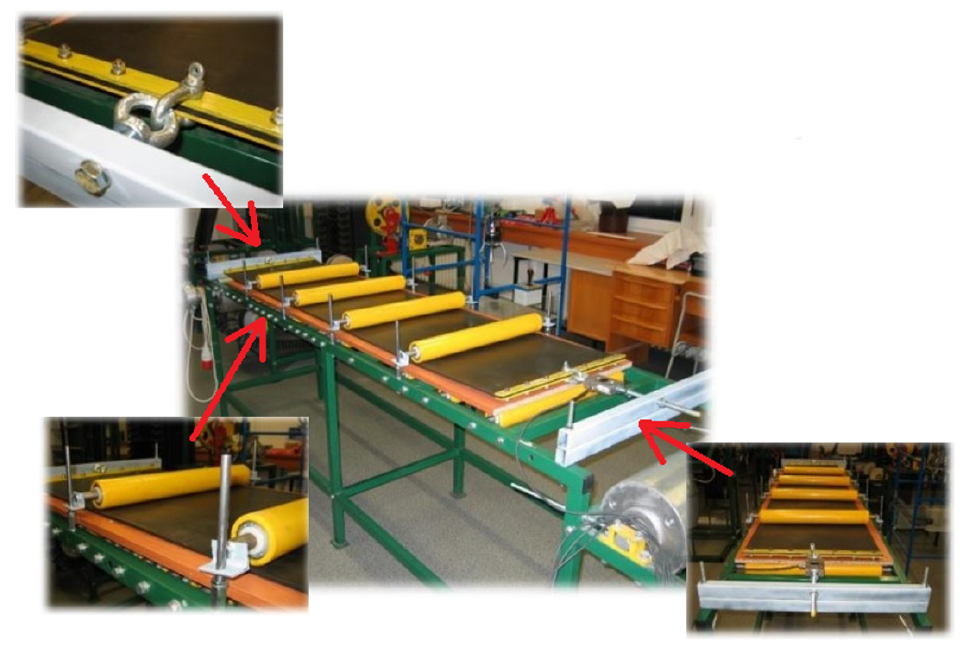
Figure 3. Implemented functional sample, called “laboratory device for measuring the transformation of a loose material layer from the applied pressure force of a conveyor roller on a pressure belt”.